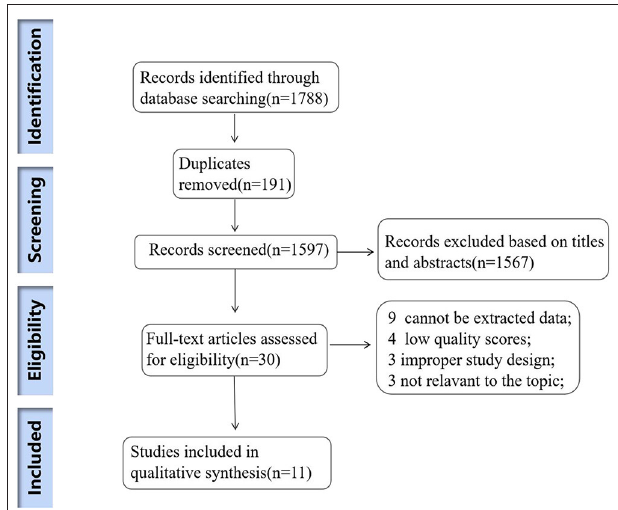
FIGURE 1 | Flow diagram of the study selection